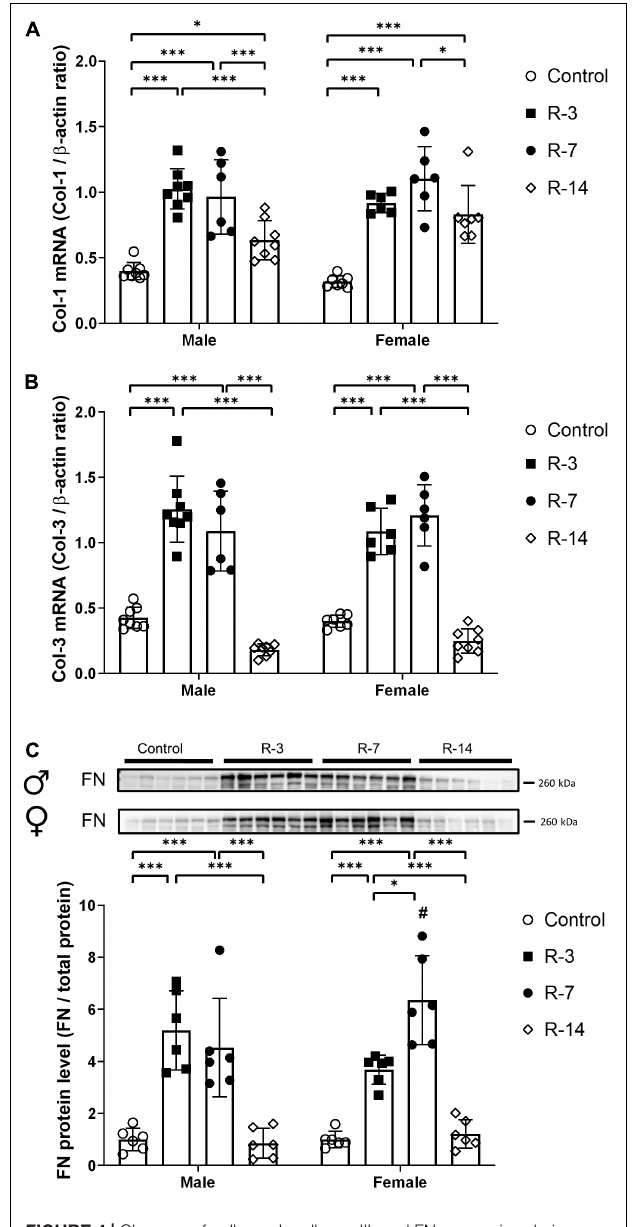
FIGURE 4 | Changes of collagen I, collagen III, and FN expression during 14 days after release of 24 h total bladder outlet obstruction. (A) Col-1 mRNA expression was significantly increased at 3, 7, and 14 days post release in both genders. (B) Col-3 mRNA expression was significantly increased at 3 and 7 days post release, and it was back to control level again at 14 days post release. Relative mRNA expression was calculated using the reference gene β -actin ( n = 8, 8, 6, and 8 in the male control, R-3, R-7, and R-14 group, respectively; n = 7, 6, 6, and 8 in the female control, R-3, R-7, and R-14 group, respectively). (C) Representative Western blots of FN showing increased FN protein levels at 3 and 7 days post release in both genders. At 14 days post release, FN protein levels were back to control levels. FN protein levels were lower in the male R-14 than in the female R-14 group. Quantification of protein expression relative was normalized by total protein ( n = 6 in all groups). Male, Female. Data are presented as means ± SD. ∗ P < 0.05 and ∗∗∗ P < 0.01. # P < 0.05 compared between genders with the ♂ ♀ corresponding